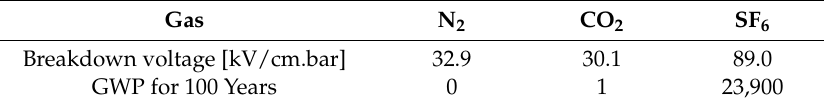
Table 6. Comparison of breakdown voltages of natural gases with SF 6